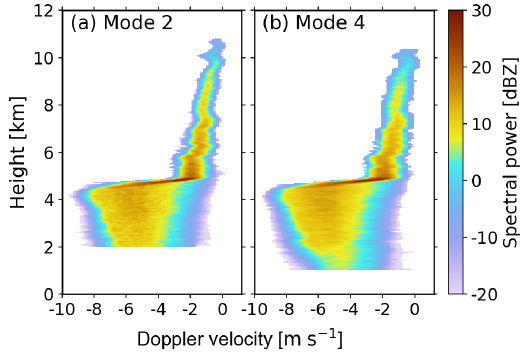
Figure 8. Doppler power spectra after removing range sidelobe at modes 2 and 4 on 6 June 2020 at 22:52:08LST. The Doppler spec- tra observations before the sidelobe removal are shown in Fig. 4b 1 and d 1